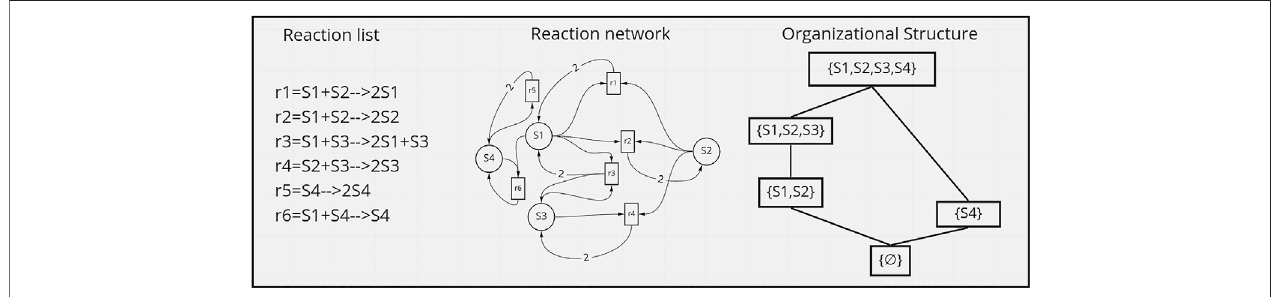
FIGURE 1 | Example of a reactions network, and its induced hierarchy of organizations. Inspired from (Veloz,